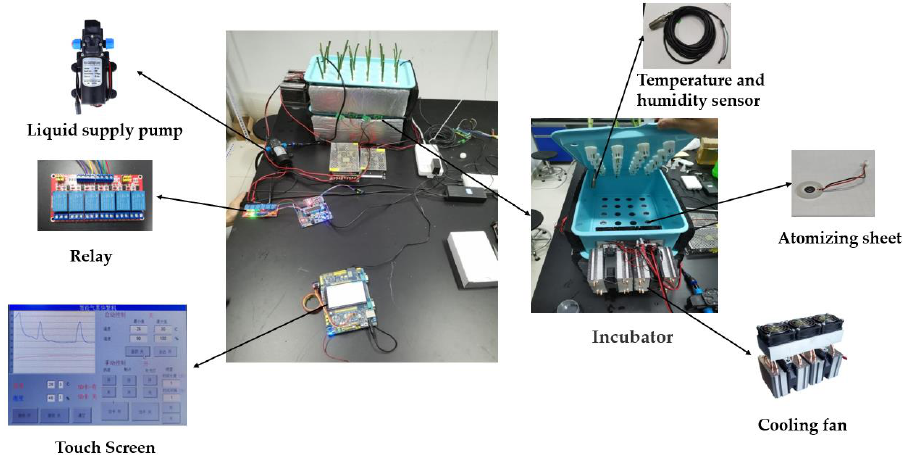
Figure 2. Schematic of hardware composition.